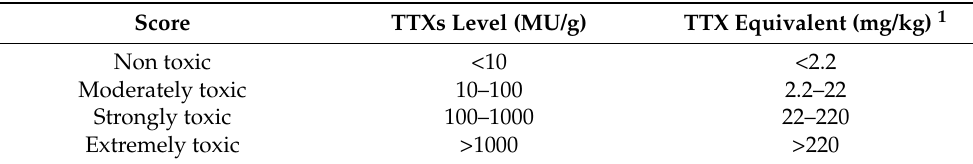
Table 2. Toxicity scores of the tissue of pufferfish.